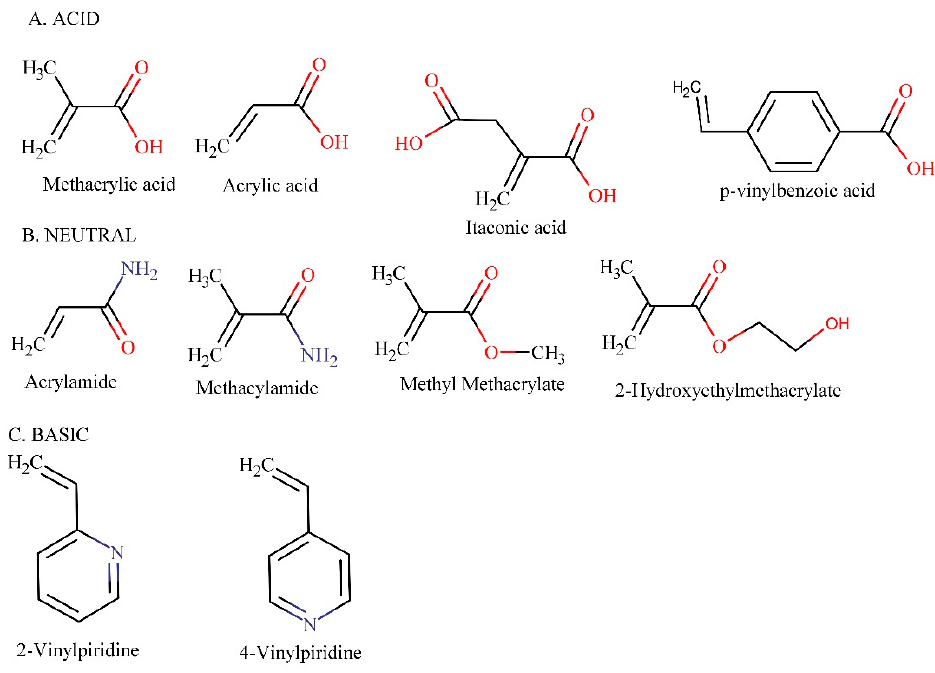
Figure 2. Functional Monomer